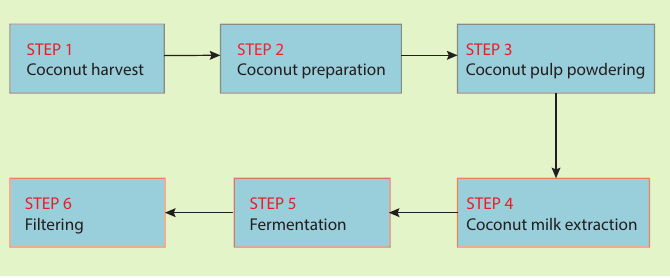
Figure 5. Fermentation-based coconut oil extraction process.